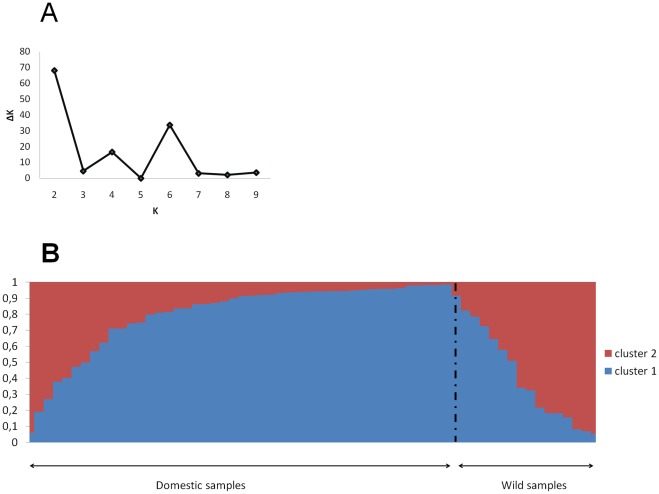
Genetic structure of wild and domesticated populations.A. Values of ΔK calculated by using the Evanno et al. (2005) method according to the number K of clusters B. Representation of the individual assignment probabilities to each of the 2 inferred clusters; individuals were arranged according to the estimated proportion of admixture in their genome.